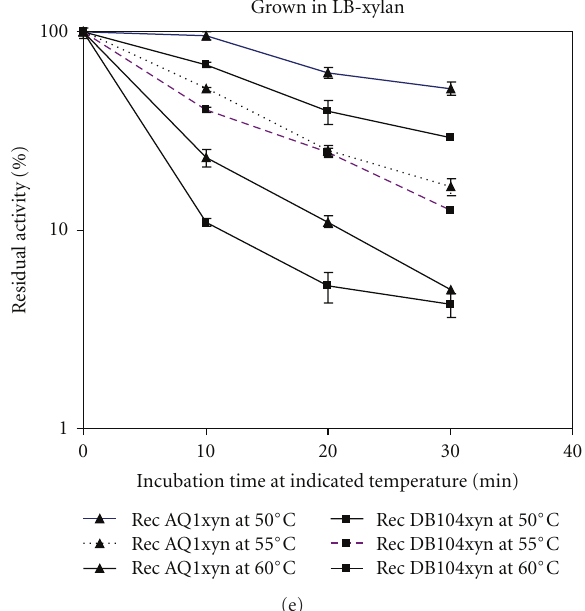
Figure 3: Recombinant E. coli s with and without xylanase activity and the comparison of properties of AQ1 and DB104 recombinant xylanase. (a) Recombinant E. coli s on LB xylan, recombinant E.coli harbouring empty pGEM-T-easy vector (1), recombinant E.coli with vector pGEM containing AQ1 xyn without native promoter (2), recombinant E.coli with vector pGEM containing AQ1 xyn with native promoter (3), and recombinant E.coli with vector pGEM containing DB104 xyn with native promoter (4). (b) The molecular mass of recombinant AQ1 endoxylanase in E. coli. For this analysis, the expression of the xylanase gene in cytoplasmic fraction with T7 promoter was used. (c) E ff ect of temperature on recombinant AQ1 endoxylanase and DB104 endoxylanase grown in LB and LB-xylan medium ( triangle was recombinant AQ1 xylanase, black one for that came from E. coli grown in LB-xylan, white one for that one grown in LB; square was DB104, black one for that one grown in LB-xylan, white one for that one grown in LB). For this temperature profile, enzymatic activity was measured in 50 mM sodium phosphate pH 7. (d) E ff ect of pH on recombinant AQ1 endoxylanase and DB104 endoxylanase from E. coli grown in LB and LB-xylan medium in di ff erent bu ff ers. The reaction pHs were adjusted to 5 − 11 with the following bu ff ers: 50mM citrate bu ff er (pH 5,6), 50 mM phosphate bu ff er (pH 6 − 8), 50 mM Tris-HCl (pH 8 − 10), and 50mM Tris-Glycine bu ff er (pH 10,11) ( triangle was recombinant AQ1 xylanase, black one for that came from E. coli grown in LB-xylan, white one for that one grown in LB; square was recombinant DB104 xylanase, black one for that one grown in LB-xylan, white one for that one grown in LB). (e) Thermostability of recombinant AQ1 endoxylanase and DB104 endoxylanase. Thermostability was determined by preincubating enzyme extract at 50, 55, and 60 ◦ C for designated time periods and then assaying the activity in pH 7.0 of 50 mM sodium phosphate at 50 ◦ C for 5 min as described in Materials and Methods. The given values in all activity assays are the means of triplicates, and the error bars indicate the standard deviation of these triplicates of independent